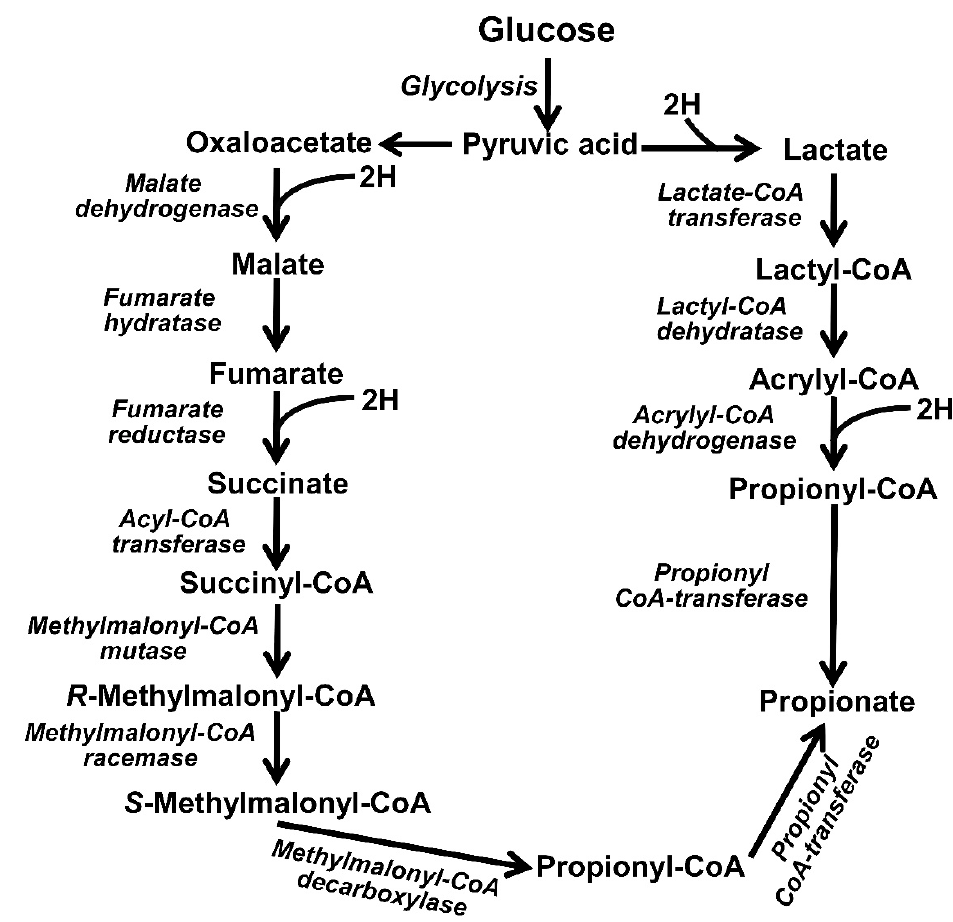
Figure 5. Pathway for propionate synthesis from oxaloacetate and lactate.